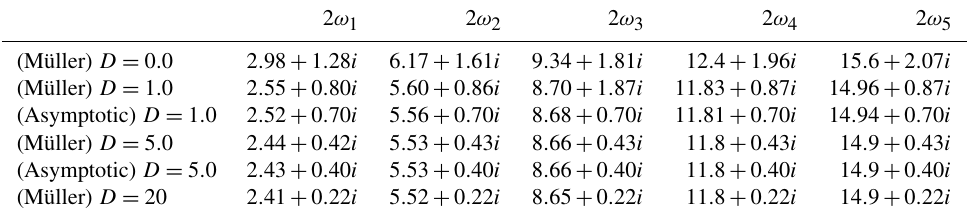
Table 1. The complex natural frequencies multiplied by 2 using both the Müller method and the asymptotic approach (see Eq. A5) for Model-1 are tabulated. Note that 2 ω k tend to the roots of J 0 for large D . All nonlinearities are neglected in calculating these frequencies. 2 ω 1 2 ω